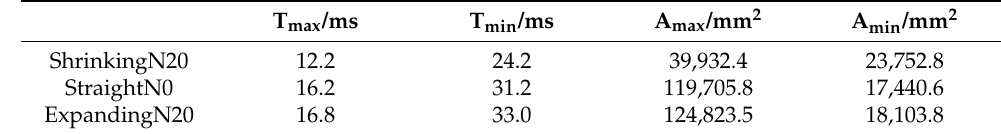
Table 2. Characteristic parameters of the bubble pulsation when different nozzles were installed.